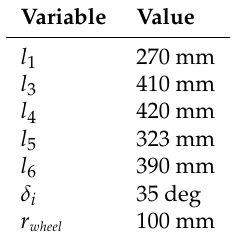
Table 4. Dimensions of the SCMS’s links.